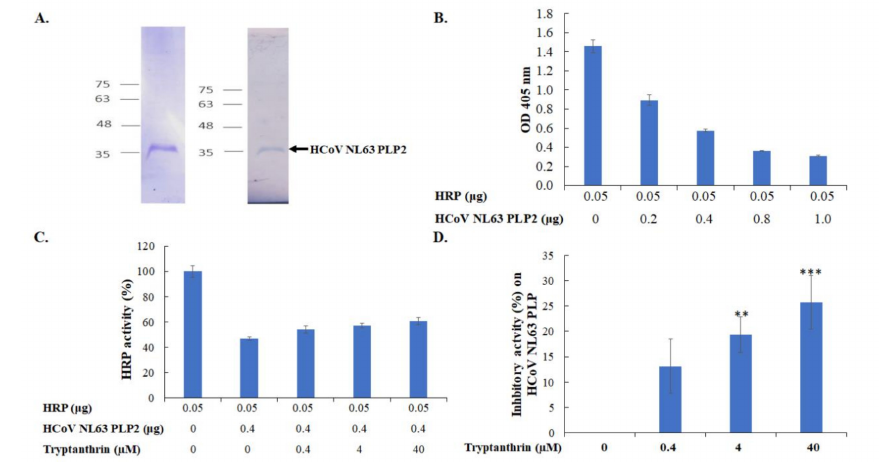
Figure 9. Inhibition of in vitro trans -cleavage activity of recombinant HCoV-NL63 papain-like protease 2 by tryptanthrin. The purified recombinant HCoV-NL63 papain-like protease 2 (PLP2) was analyzed by 10% SDS-PAGE with Coomassie blue staining ( A , right) and Western Blotting with anti-His tag antibodies ( A , left). The trans -cleavage activity of HCoV-NL63 PLP2 was evaluated using the ELISA with horseradish peroxidase (HRP) containing an LXGG motif as the substrate. After 2 h of incubation at 37 ◦ C, the enzyme activity of the residual HRP (in intact form) was detected using a chromogen reagent (ABTS / H 2 O 2 ). The ELISA product was measured at A 405 nm ( B ). Tryptanthrin at indicated concentrations was added into the mixture of HCoV-NL63 PLP2 and HRP, and then incubated for 2 h at 37 ◦ C. Lastly, the enzyme activity of the residual HRP (in intact form) was determined using the chromogen reagent (ABTS / H 2 O 2 ), calculated as 1 − (OD405 with PLP2) / (OD405 without PLP2) ( C ). Moreover, the relative inhibition of the cleavage activity of PLP2 by tryptanthrin was estimated as 1 − (OD405 without PLP2 − OD405 with PLP2 plus tryptanthrin) / (OD405 without PLP2 − OD405 with PLP2) ( D ). **, p value < 0.01; ***, p value < 0.001 compared with the mock-treated